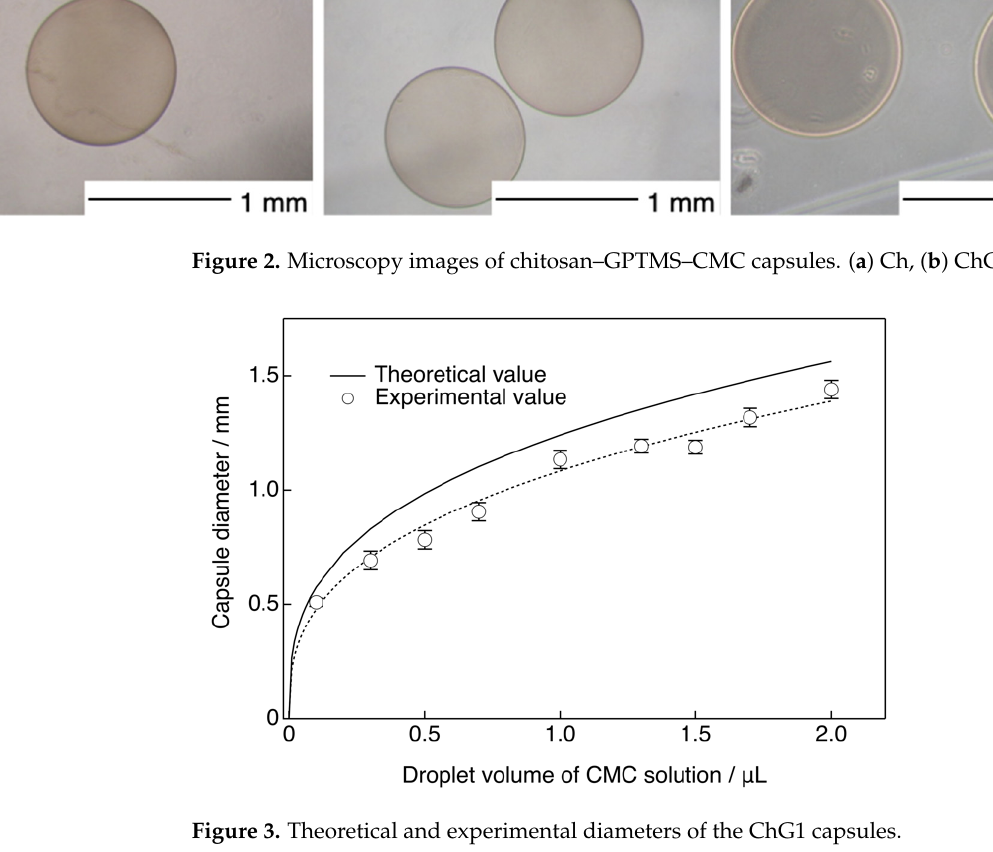
Figure 3. Theoretical and experimental diameters of the ChG1 capsules.